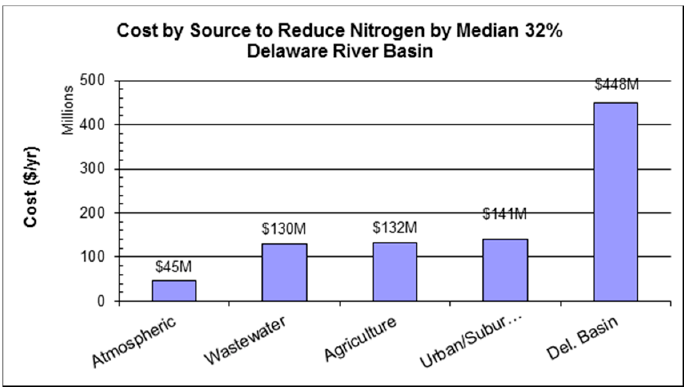
Figure 11. Least cost (in 2010 dollars) by source to reduce nitrogen loads by 32% in Delaware Basin.